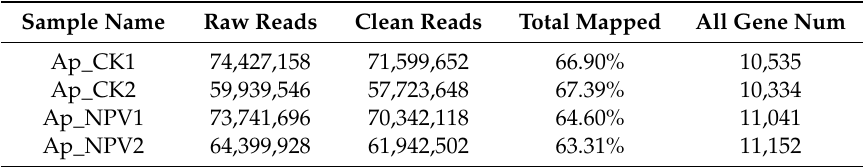
Table 1. RNA-Seq data statistics.